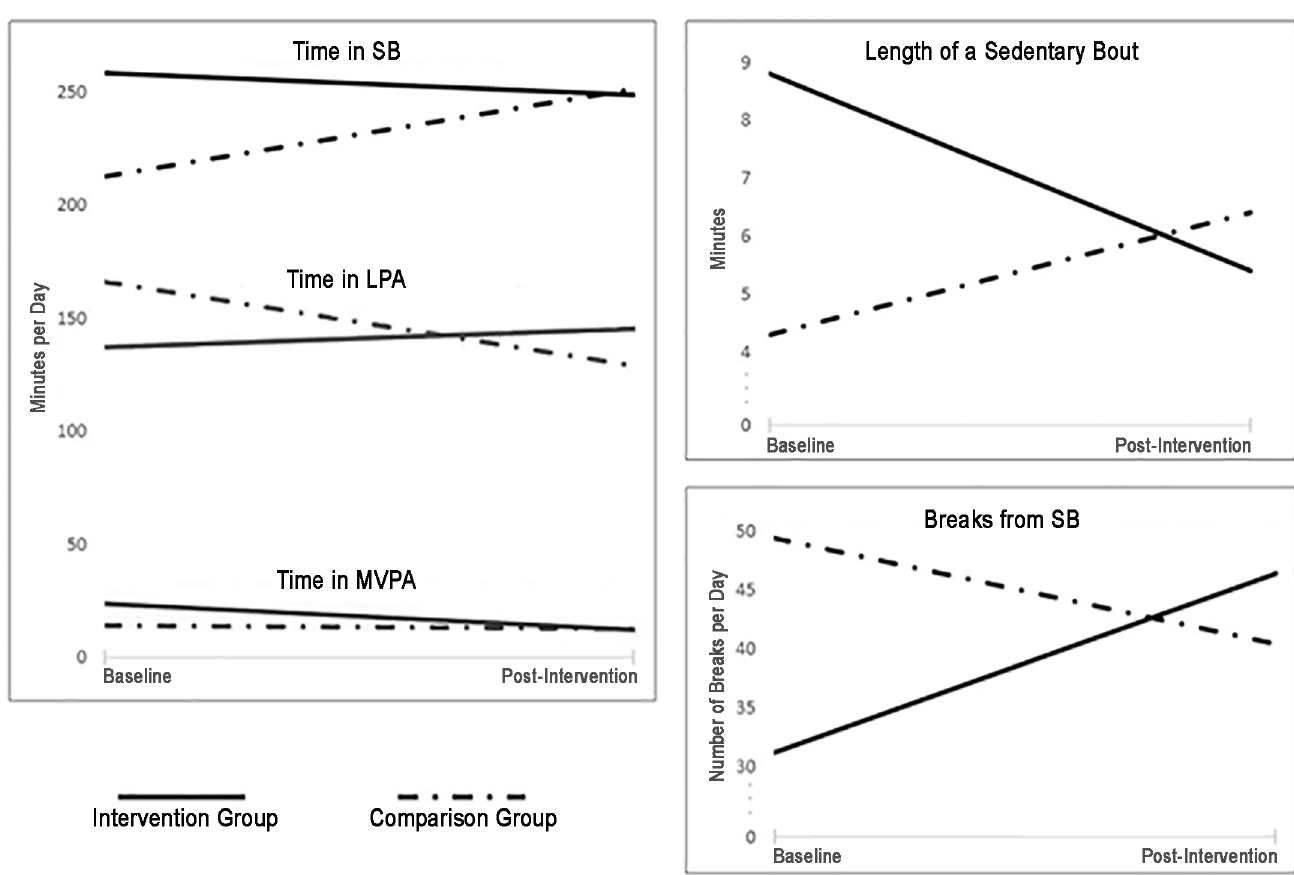
Fig 2. Baseline and post-intervention outcomes of intervention and comparison